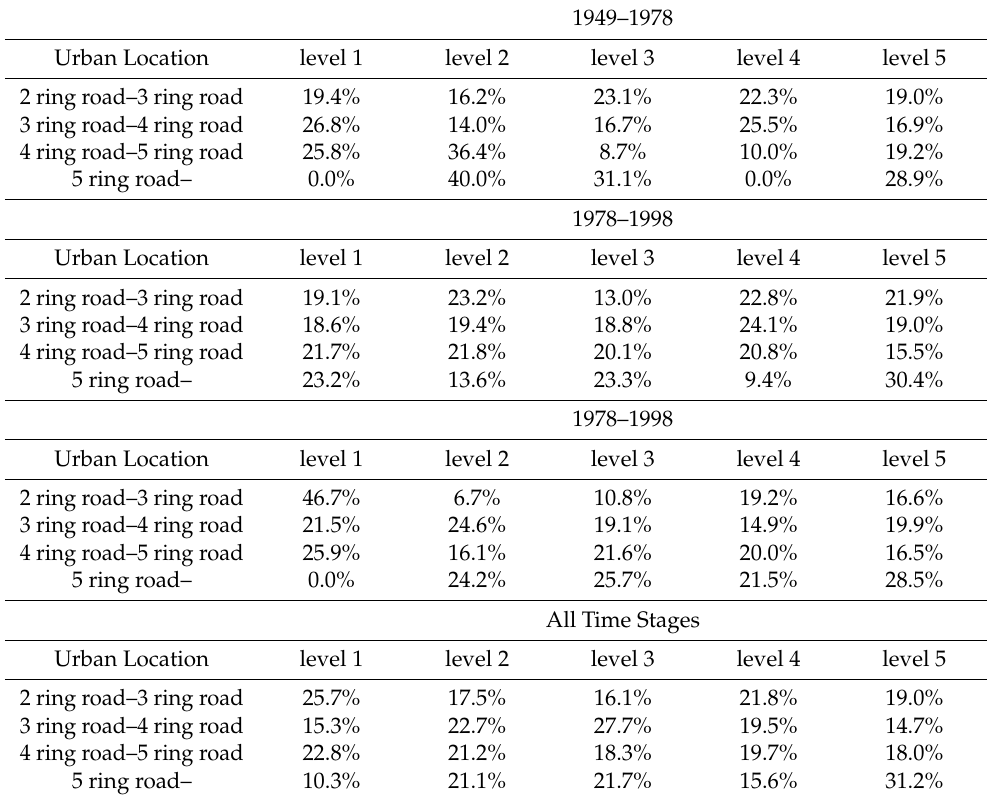
Table 5. Specific measurement results of the Time Distance Entropy